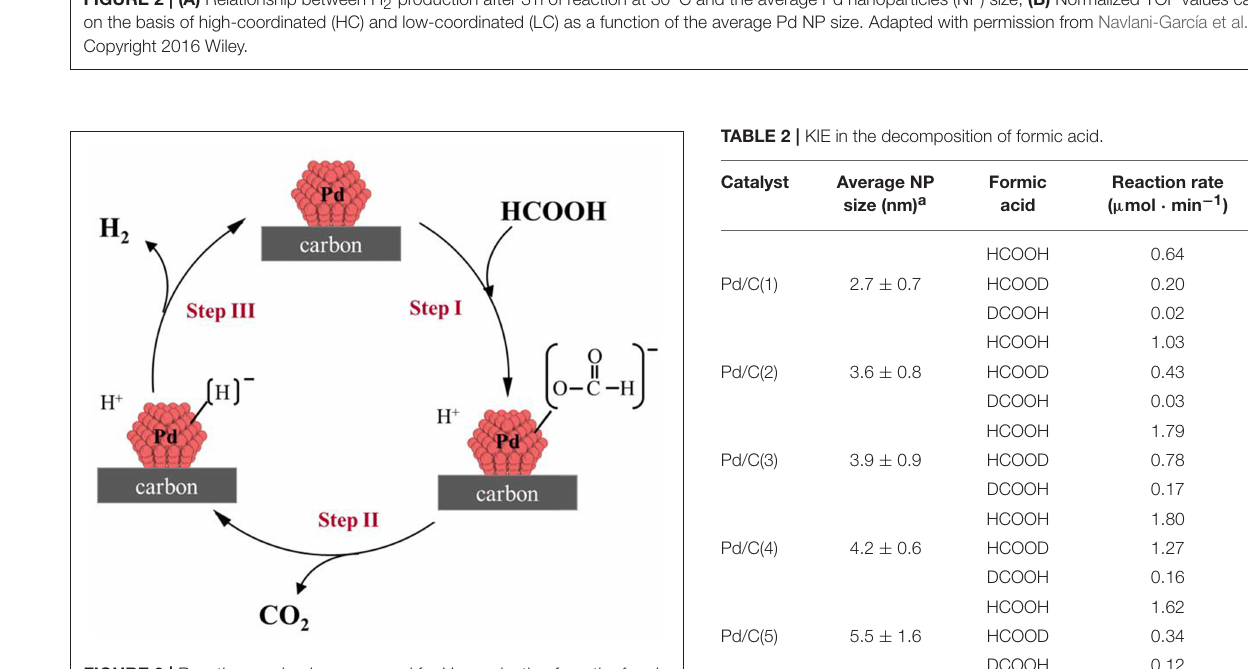
FIGURE 3 | Reaction mechanism proposed for H 2 production from the formic acid dehydrogenation catalyzed by Pd/C catalysts.